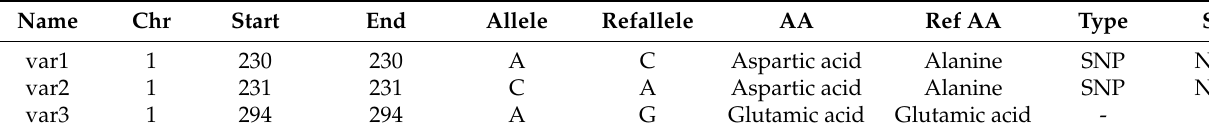
Table 6. NovelSNPer detailed output file with transcript variation per line.